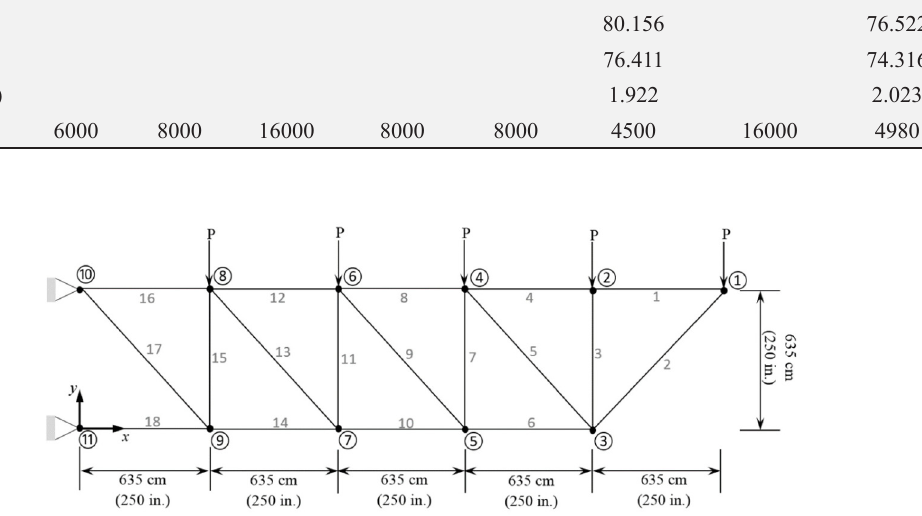
Design variables